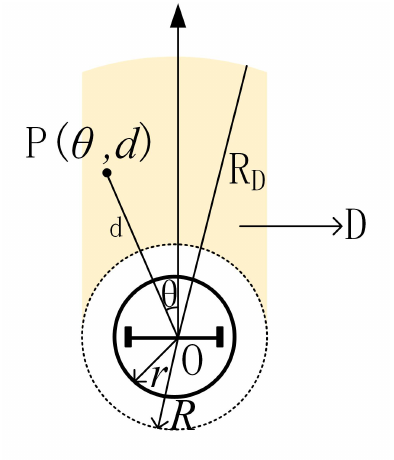
Figure 8. Representation of region D